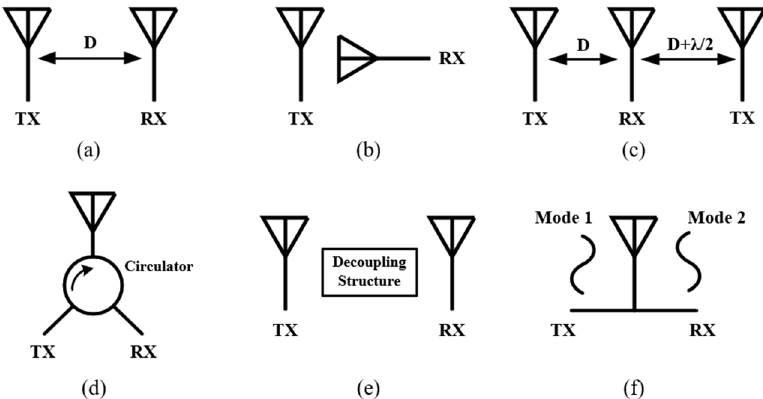
Figure 3. Passive SIC techniques in the AP domain. ( a ) Antenna separation. ( b ) Polarization orthogonality. ( c ) Near-field cancellation. ( d ) Isolation feed network. ( e ) Decoupling surface/structure. ( f ) Orthogonal antenna modes.